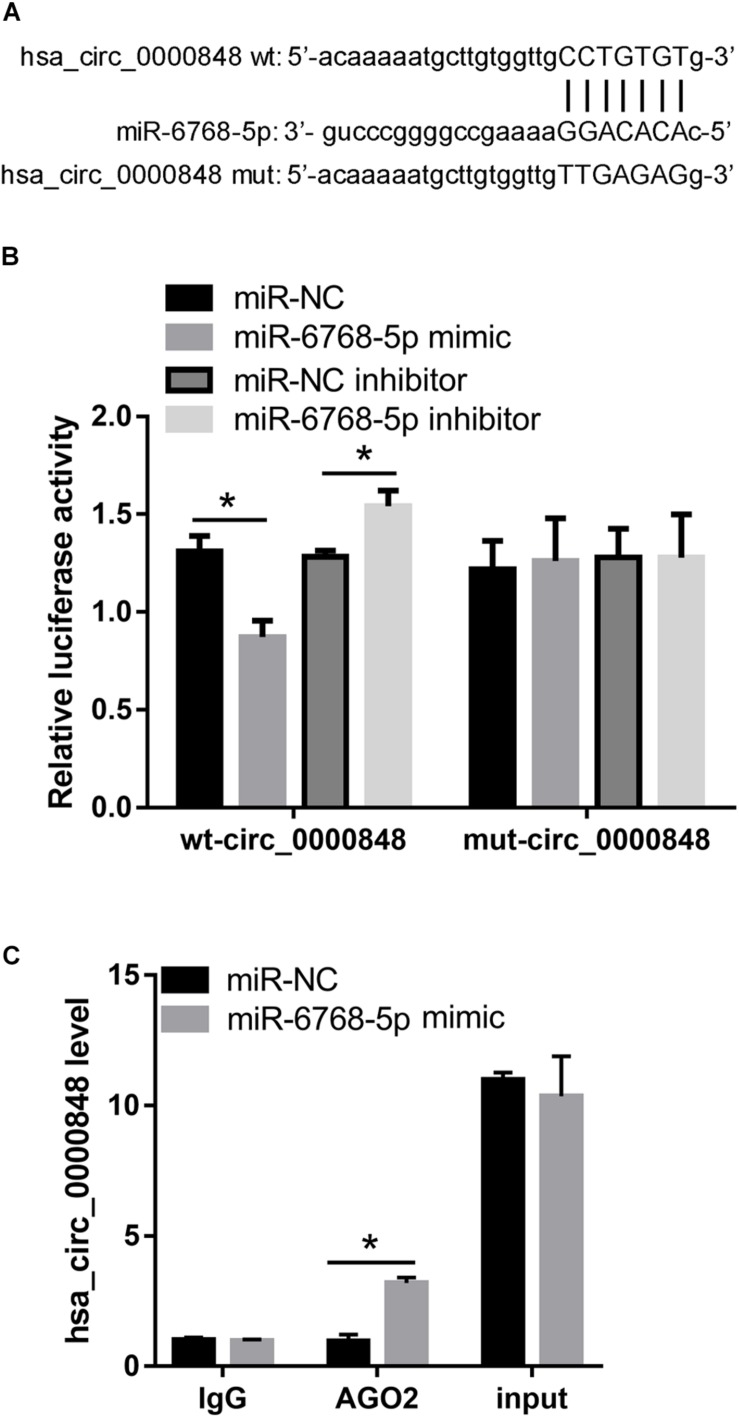
hsa-miR-6768-5p can bind to hsa_circ_0000848 in HTR-8 cells. (A) The binding site of hsa-miR-6768-5p on hsa_circ_0000848 and the mutant information for hsa_circ_0000848 in the dual luciferase activity assay. (B) Results of the dual luciferase activity assay. (C) Results of the anti-AGO2 immunoprecipitation (RIP) assay. hsa_circ_0000848 levels in purified RNA collected from products of anti-AGO2 or anti-IgG RIP assay and cell lysate before immunoprecipitation (input) was detected by RT-qPCR. *P < 0.05 using unpaired t-tests. wt, wild type; mut, mutant.